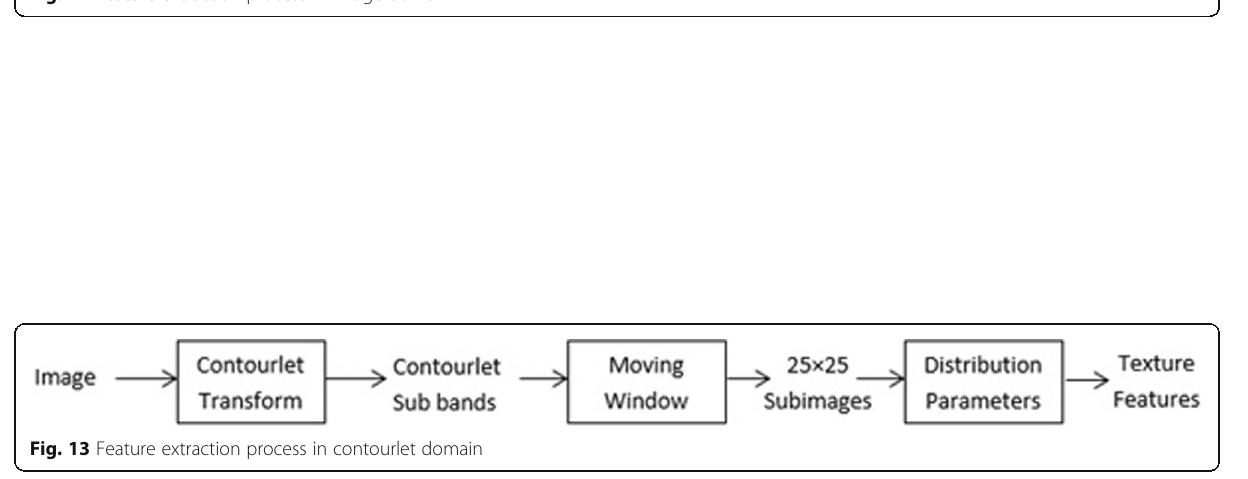
Fig. 12 Feature extraction process in image domain